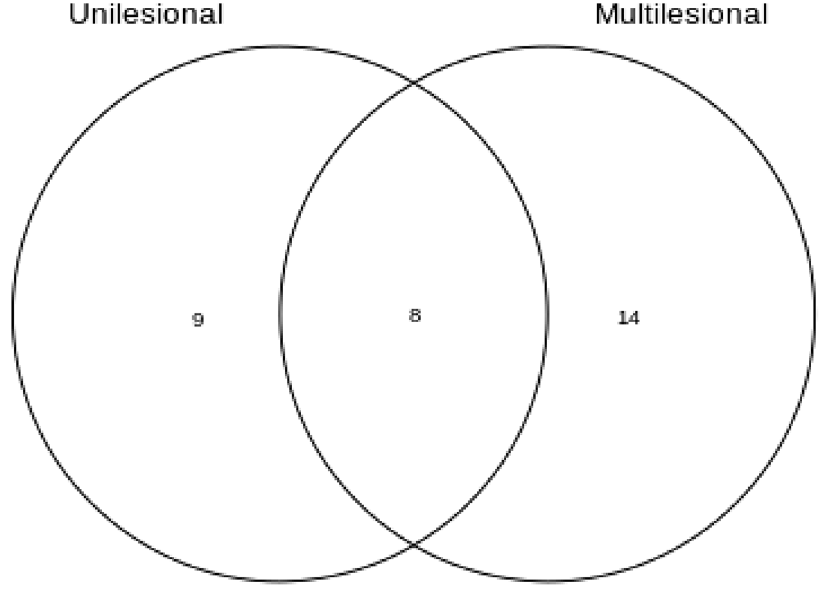
Figure 1. Veen diagram analysis of Variant Enrichment Analysis (VEA) of 11 exomes from patients with Pyoderma gangrenosum classified by disorder’s severity. 8 enriched pathways (EP) are shared between “unilesional” and multilesional. 9 and 14 EP exclusive in “unilesional” and multilesional respective.